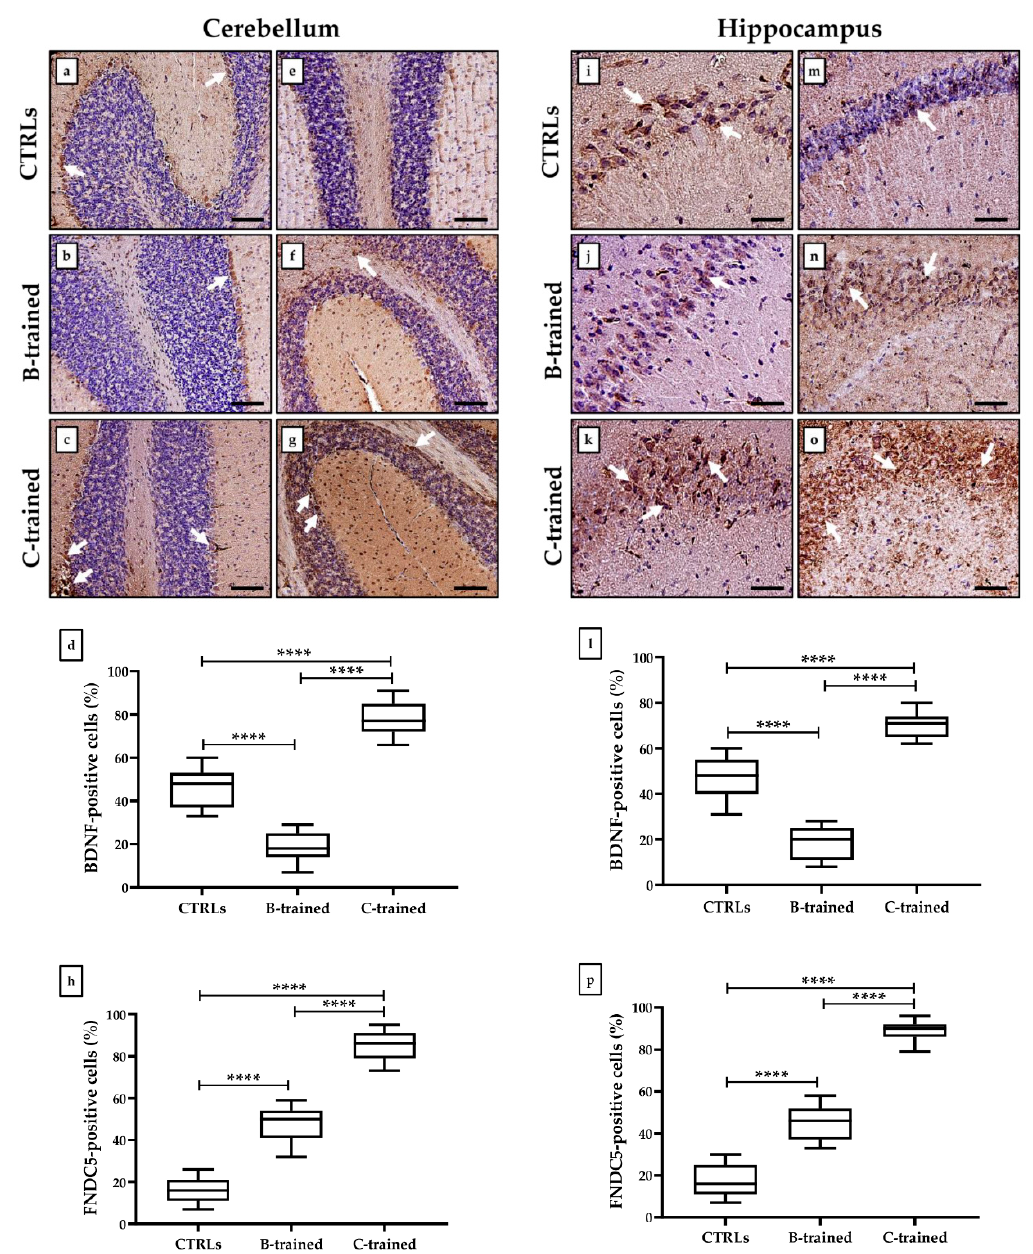
Figure 3. Brain-derived neurotrophic factor (BDNF) and fibronectin type III domain-containing protein 5 (FNDC5) expression analysis in cerebellar and hippocampal tissues of trained and sedentary mice by immunohistochemistry. ( a – c ) Arrows indicate representative BDNF-positive cells in the cerebellum. ( d ) The highest number of BDNF-positive cells was found in the cerebellum of the C-trained group (**** p < 0.0001; F = 209.7). ( e – g ) Arrows indicate representative FNDC5-positive cells in the cerebellum. ( h ) The highest number of FNDC5-positive cells was found in the cerebellum of the C-trained group (**** p < 0.0001; F = 353.2). ( i – k ) Arrows indicate representative BDNF-positive cells in the hippocampus. ( l ) The highest number of BDNF-positive cells was found in the hippocampus of the C-trained group (**** p < 0.0001; F = 198.1). ( m – o ) Arrows indicate representative FNDC5-positive cells in the hippocampus. ( p ) The highest number of FNDC5- positive cells was found in the hippocampus of the C-trained group (**** p < 0.0001; F = 413.3). 20× images, scale bar represents 50 μ m.